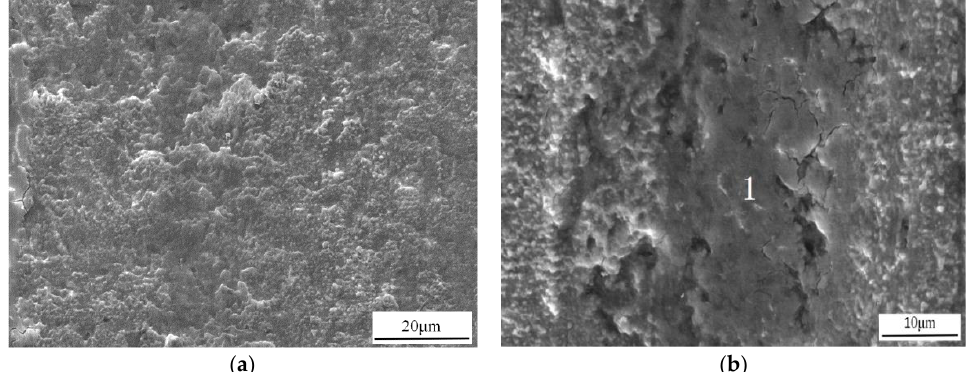
Figure 5. High magnification image of the worn surface for ( a ) SN0 pin sample and ( b ) SN20 pin sample against UHMWPE under SBF lubrication.